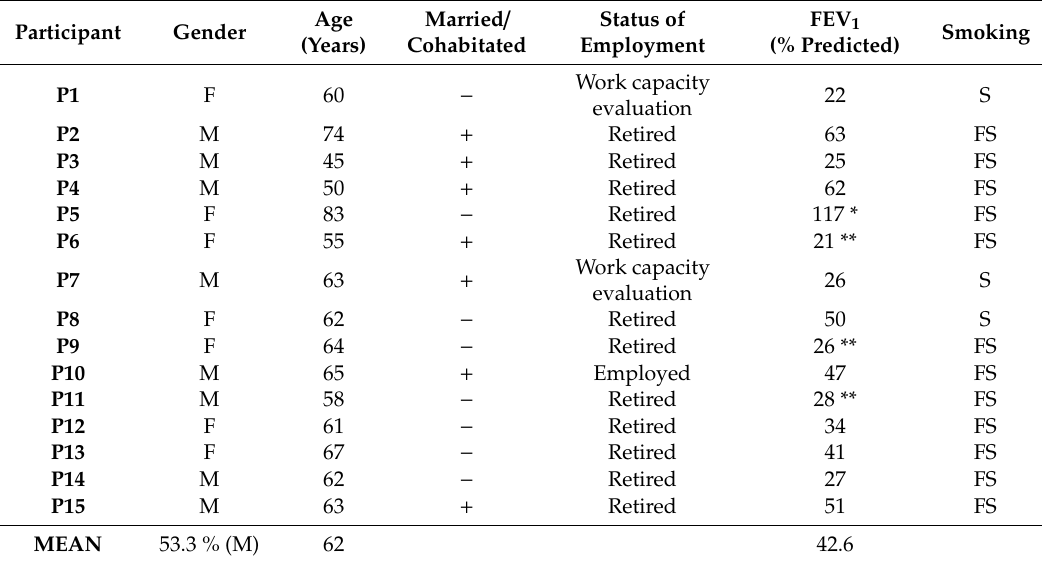
Table 1. Characteristics of the participants in >